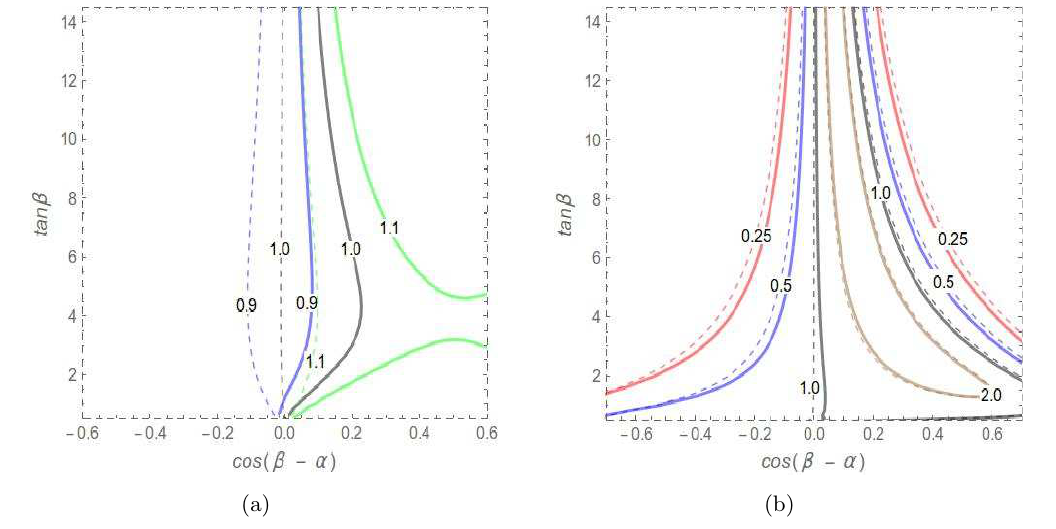
Figure 5 . Dashed and solid lines represent respectively for 2HDM at tree-level and for BP3 of 2HDMEFT, contours of (a) σ ( gg